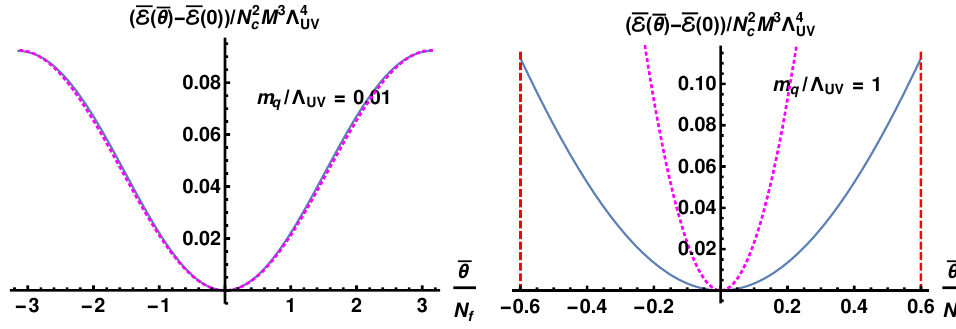
Figure 2. The dependence of the free energy on the ¯ θ -angle at x = 2 / 3 for m q = 0 . 01 (left plot) and m q = 1 (right plot). The dashed magenta curves are again predictions from chiral Lagrangians. The dashed red vertical lines denote where the solution ceases to exist for m q = 1.